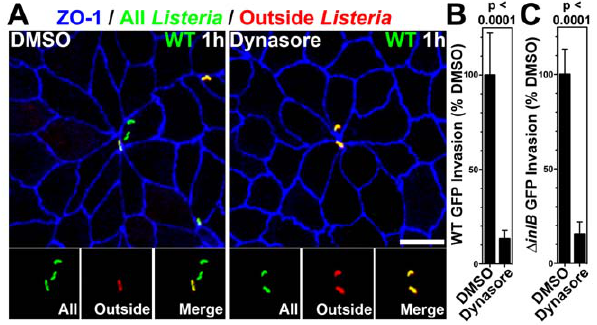
Figure 4. Dynamin-dependent invasion of MCJs. (A) Polarized MDCK cells were pretreated with DMSO or dynasore for 30 minutes and then infected with GFP-expressing WT Lm for 1 h. To evaluate intracellular versus extracellular bacteria, we performed an outside staining where extracellular adherent GFP-expressing Lm were stained before permeabilization in red. Intracellular Lm are green and external Lm are a combination of red/green or yellow. Monolayers were counterstained with antibodies to ZO-1, blue. Scale bars 10 m m. (B) Quantification of relative WT Lm invasion of Polarized MDCK monolayers pretreated with DMSO or dynasore for 1 h. Relative mean and SD of intracellular CFUs recovered after gentamicin treatment are shown. p , 0.0001. (C) Quantification of relative D inlB Lm invasion of Polarized MDCK monolayers treated with DMSO or dynasore. Relative mean and SD of intracellular CFUs recovered after gentamicin treatment are shown. p , 0.0001.